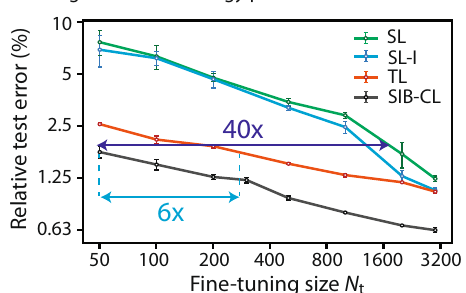
Fig. 5 3D Time-independent Schrödinger Equation (TISE). a 3D random `in-a-box' potentials and their associated ground-state energies, E 0 . b Left: The surrogate dataset was generated by reducing the input unit cell resolution from 32×32×32 to 5×5×5. Right: The relative numerical error of E 0 at various discretization points N when compared to N = 128 (the `theoretical' value) shows that N = 5 ( N = 32) is a good choice for the reduced (original) resolution since it gives a relatively high (low) error of 10% (0.1%). Error bars show 1 σ uncertainty over 10 random samples. c Network prediction error against fi ne-tuning dataset sizes N t for SIB-CL and the baselines on the TISE problem. The plot for SIB-CL shows the best results among the two contrastive learning techniques, SimCLR 53 and BYOL 54 . Error bars show the 1 σ uncertainty when varying dataset selection. SIB-CL was seen to give up to 40×(6×) data savings when compared to SL